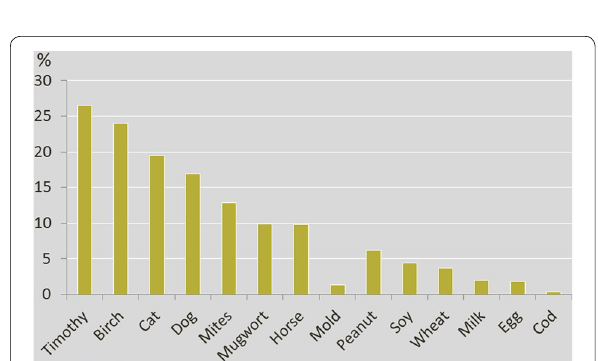
Fig. 3 Proportions of individuals with sIgE-sensitization at the 24-year follow-up in the population-based birth cohort BAMSE (n 2234). Timothy n 594, birch n 541, cat n 438, dog n 379, = = = = = mites n 290, mugwort n 221, horse n 219, mold n 30, peanut = = = = n 138, soy n 98, wheat n 82, milk n 44, egg n 42, cod n = = = = = =